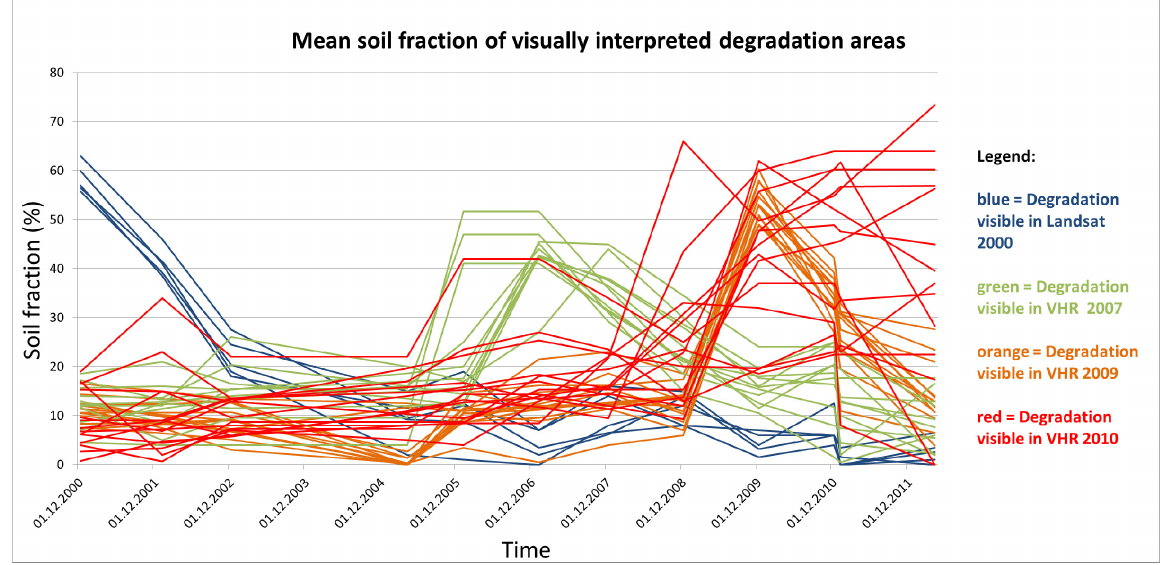
Figure 5. Performance of the temporal behavior of mean soil fraction values of degradation areas from different years in the Cameroon study